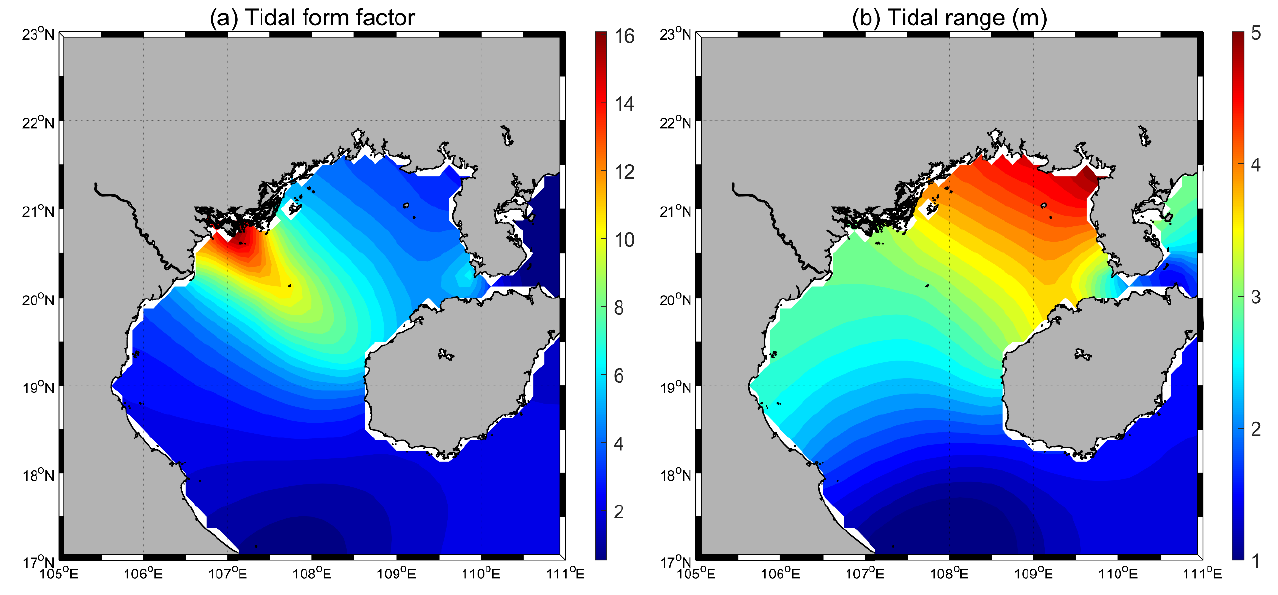
Figure 2. ( a ) Tidal form factors ( b ) Tidal ranges (unit: m) in the Gulf of Tonkin. Tidal constants are derived from EOT20 model (Hart-Davis et al., 2021) [22].